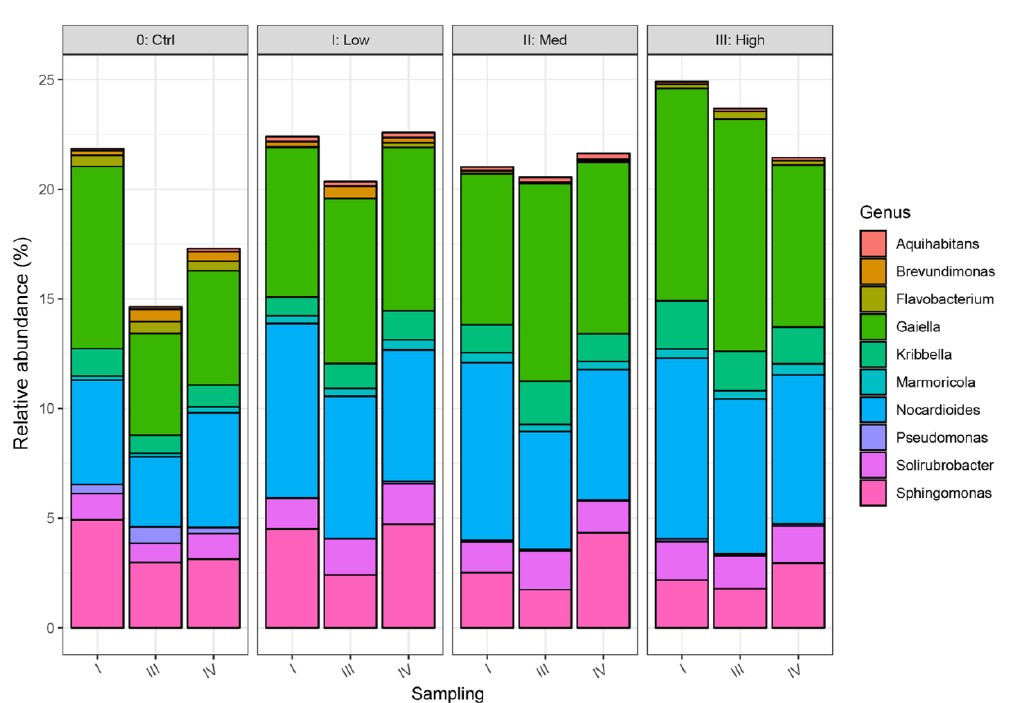
Figure 6. Most abundant genus in loamy soil as result of water stress. Ctrl, Low, Med, High—optimal moisture and low, medium and high water stress, respectively; I, III, IV—sampling